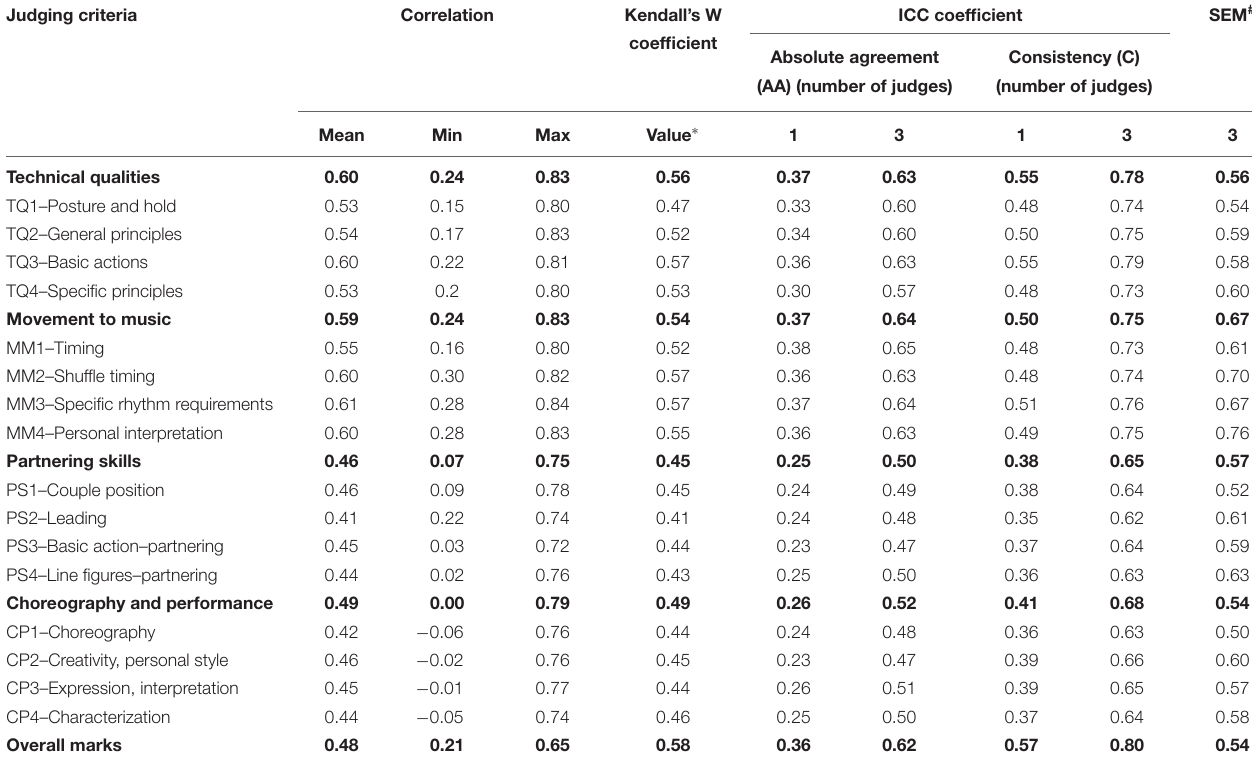
TABLE 3 | Reliability of judging of all main and